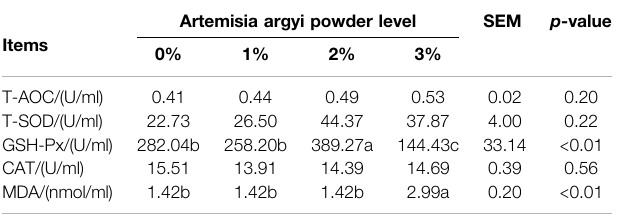
TABLE 5 | Effects of Artemisia argyi on Serum Antioxidant Indices of Roman Laying Hens.